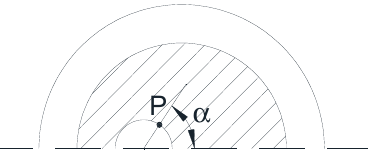
Figure 2. Angle α defining a point P of the crack front.